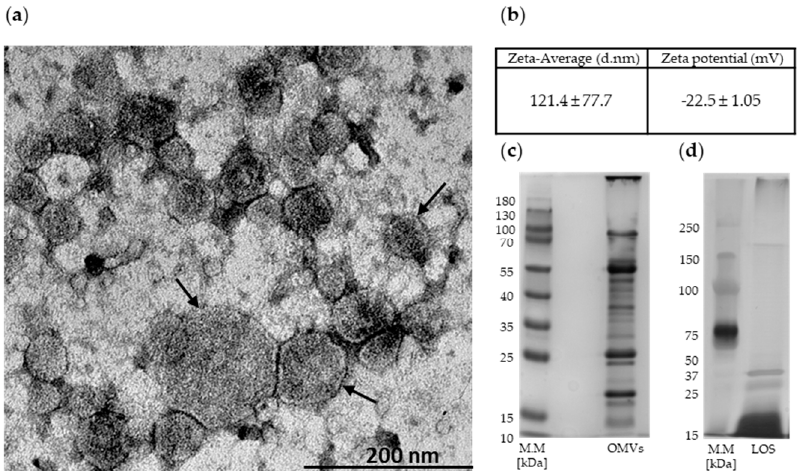
Figure 1. Physical characterization of outer membrane vesicles (OMVs) released from Mc6 cells: ( a ) TEM image of OMVs, vesicles are indicated by arrows (magnification, × 50,000); ( b ) the size distribution by volume and the zeta potential of vesicles, as assessed by the Zeta-sizer; each experiment was performed in triplicate; ( c ) the respresentative proteinogram of 12% SDS-PAGE electrophoresis of OMVs; the protein profiles were visualized using Coomassie staining; ( d ) the representative 10% SDS-PAGE electrophoresis of lipooligosaccharide (LOS)-OMVs visualized by silver staining .